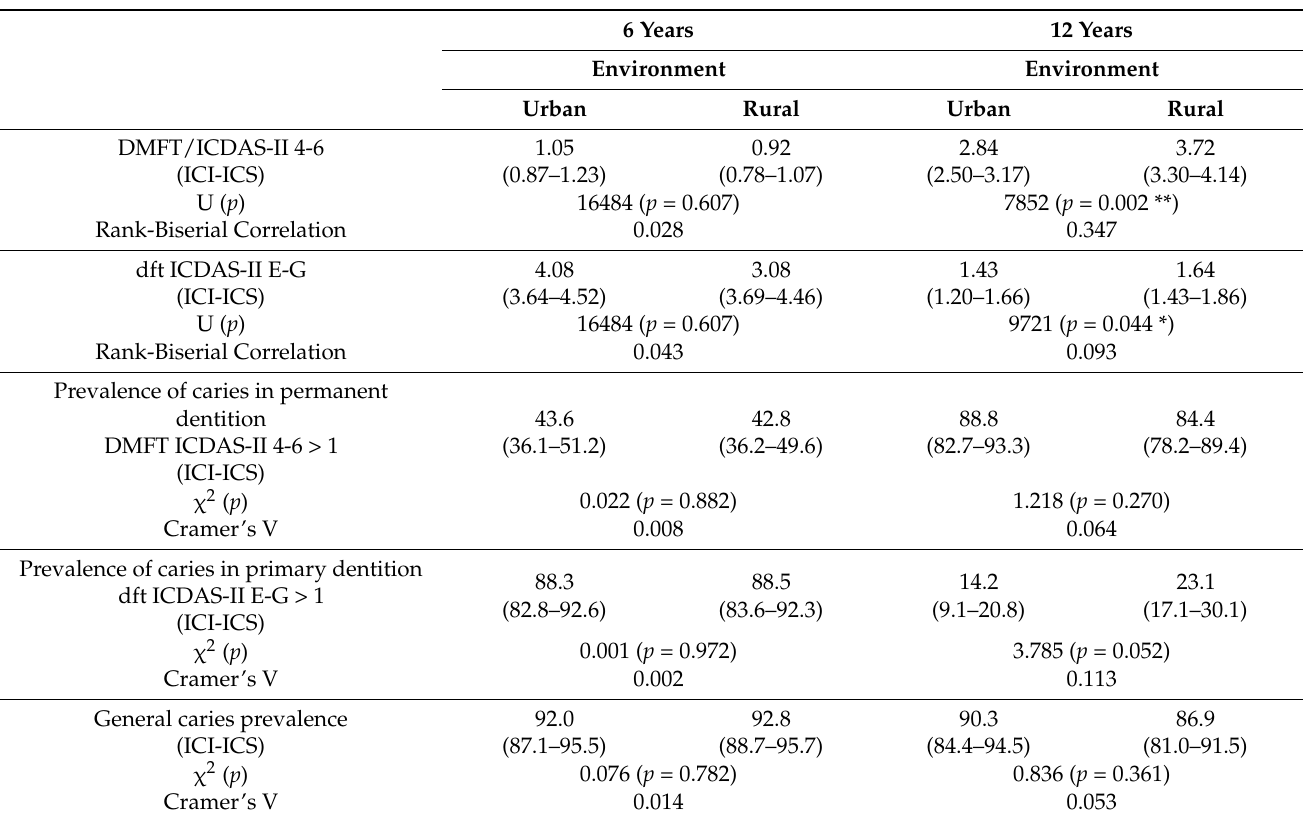
Table 2. Main caries indicators according to the ICDAS II 4-6/E-G criteria in each age group according to environment.